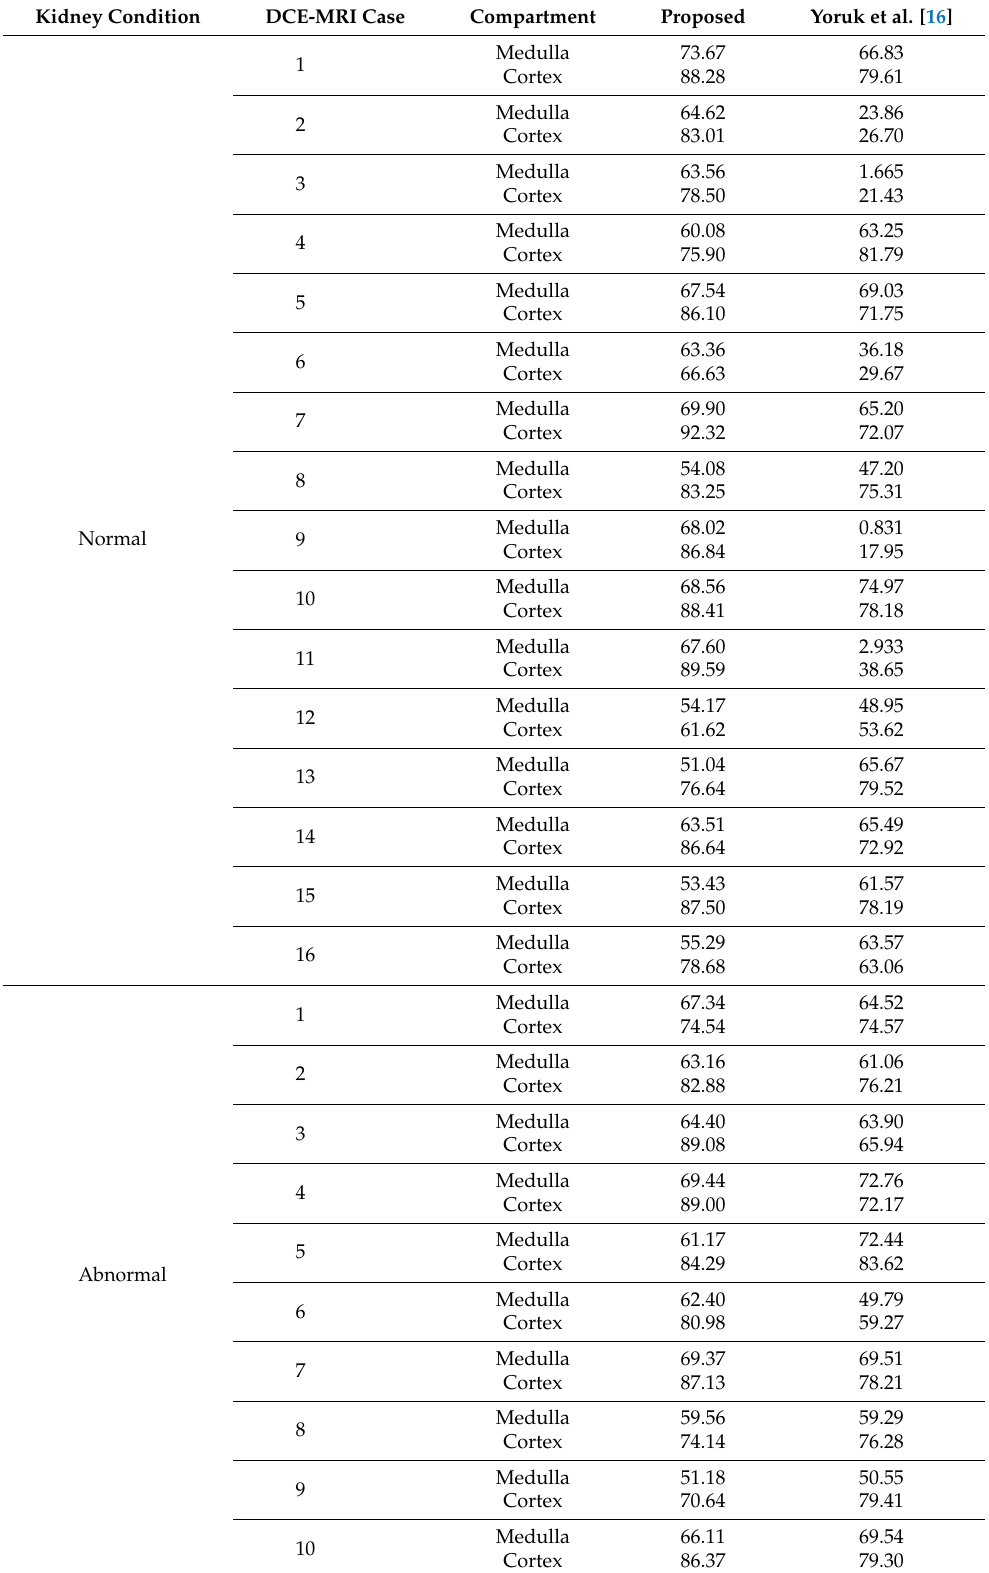
Table 2. Individual medulla and cortex segmentation